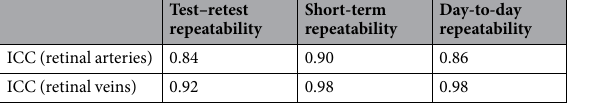
Table 3. Intraclass Correlation Coefficients for the Repeatability Measurements in Healthy Subjects. ICC, intraclass correlation coefficient.